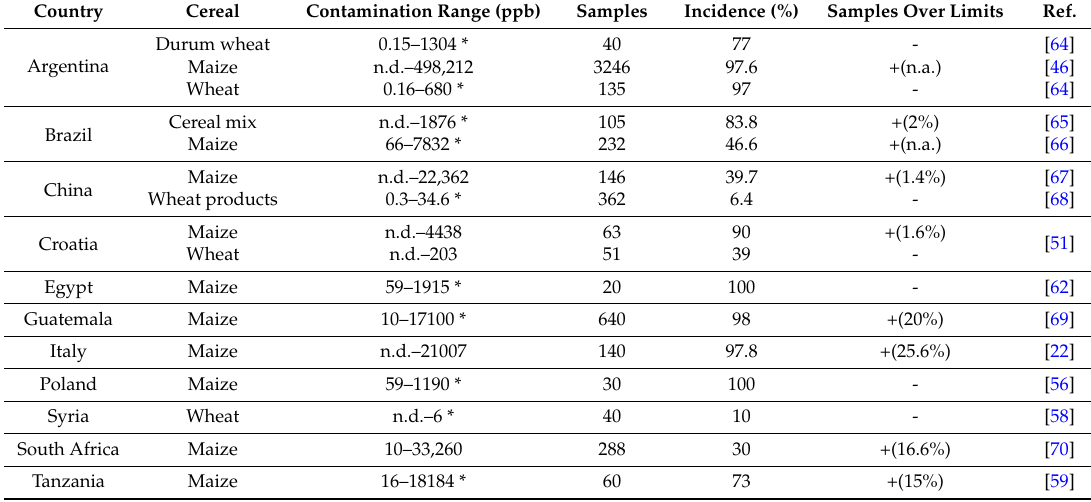
Table 4. Percentage and level of contamination in different countries and commodities relative to B 1 and B 2